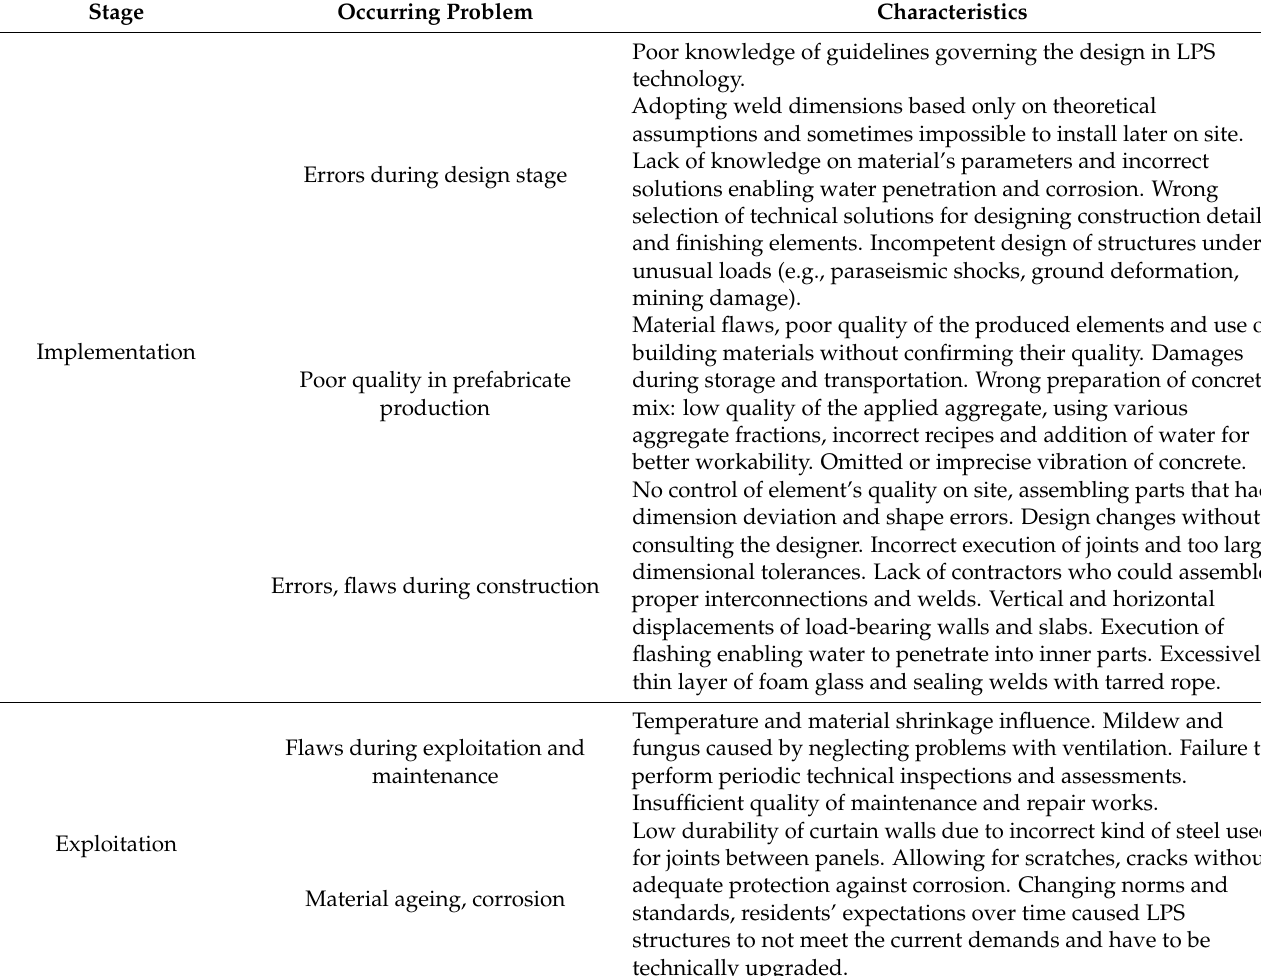
Table 5. The most popular defects on each stage of erecting a building in large panel system technology (based on the information provided in